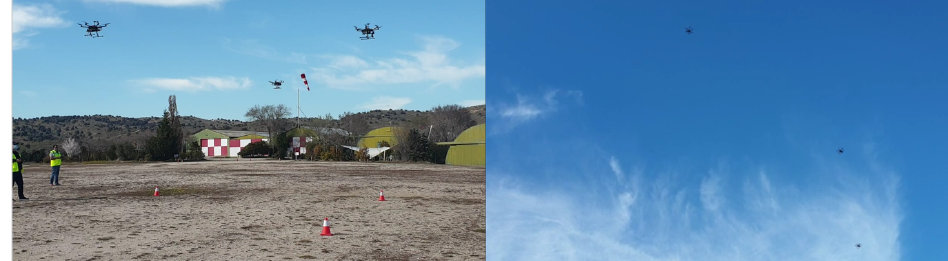
Figure 14. Pictures of the real implementation.